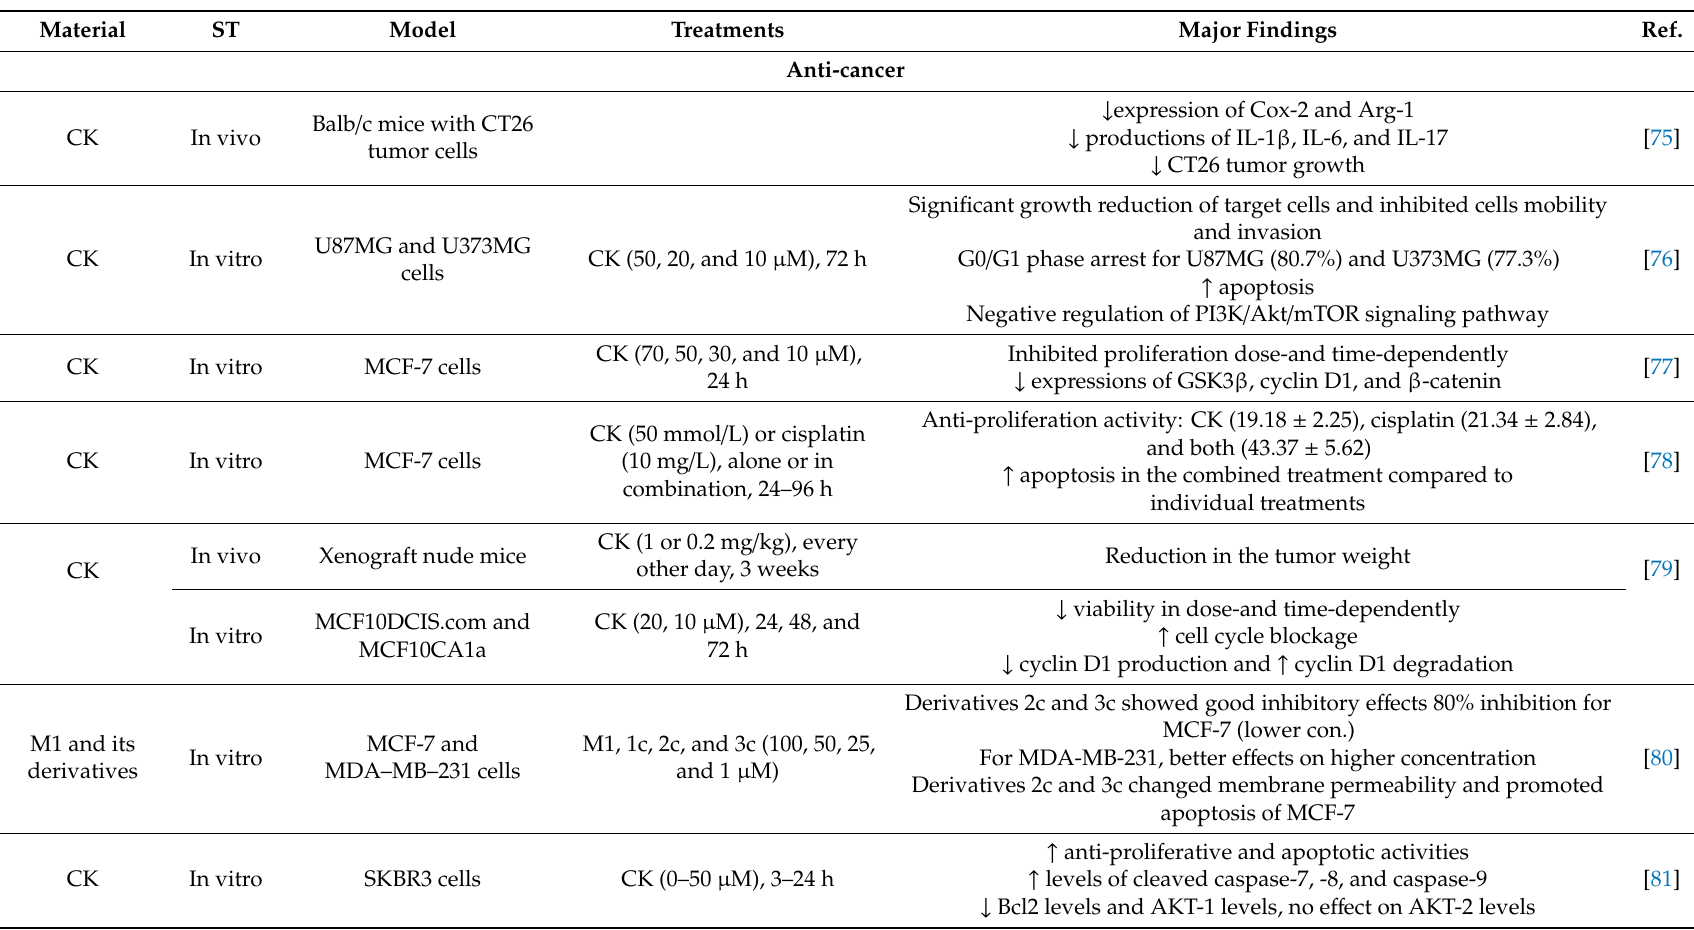
Table 4. Anti-cancer, neuroprotection, anti-aging / skin protection, and other activities of CK and its